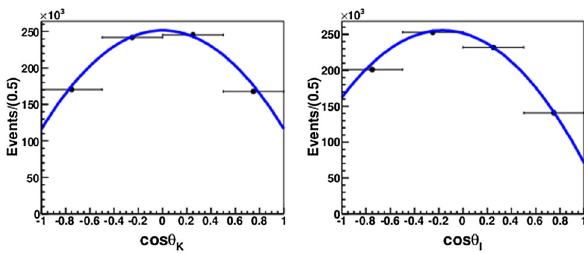
Fig. 5 Efficiency corrected signal yields in bins of cos θ K (left) and cos θ l (right). The curve is the result of fit using polynomial